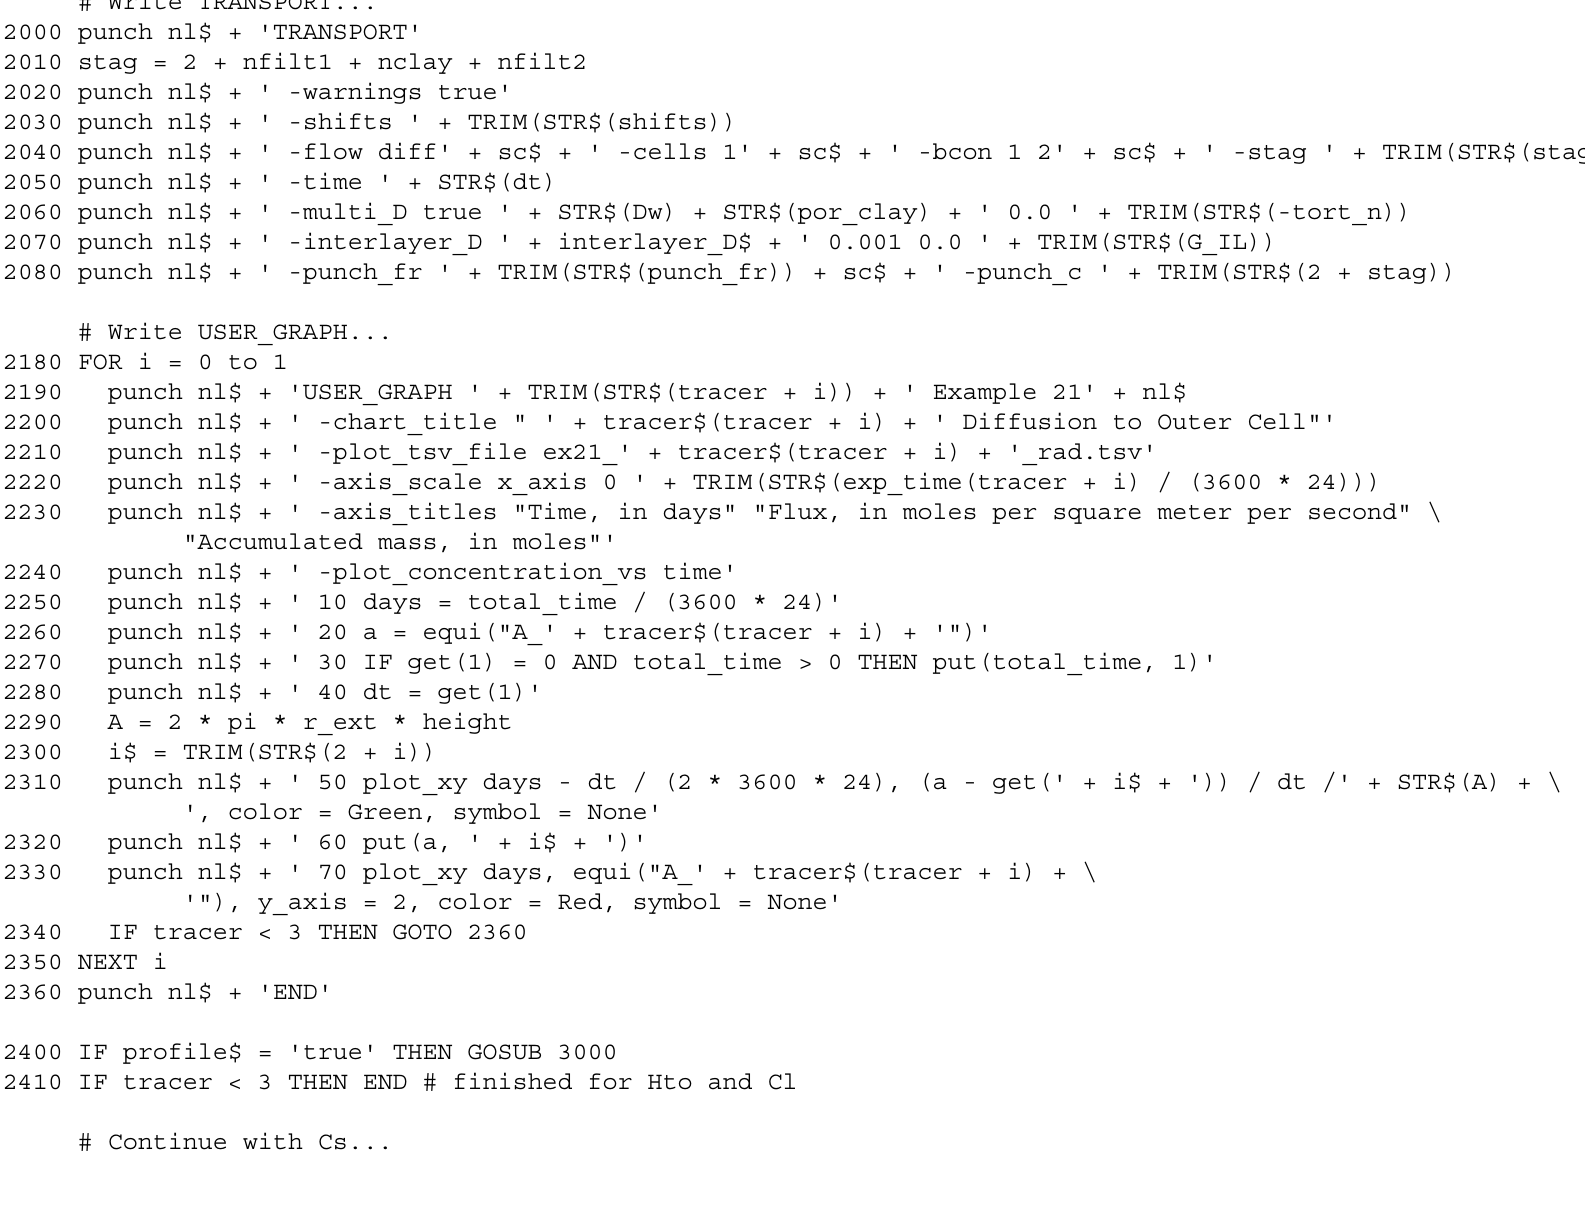
Table 60. Input file for example